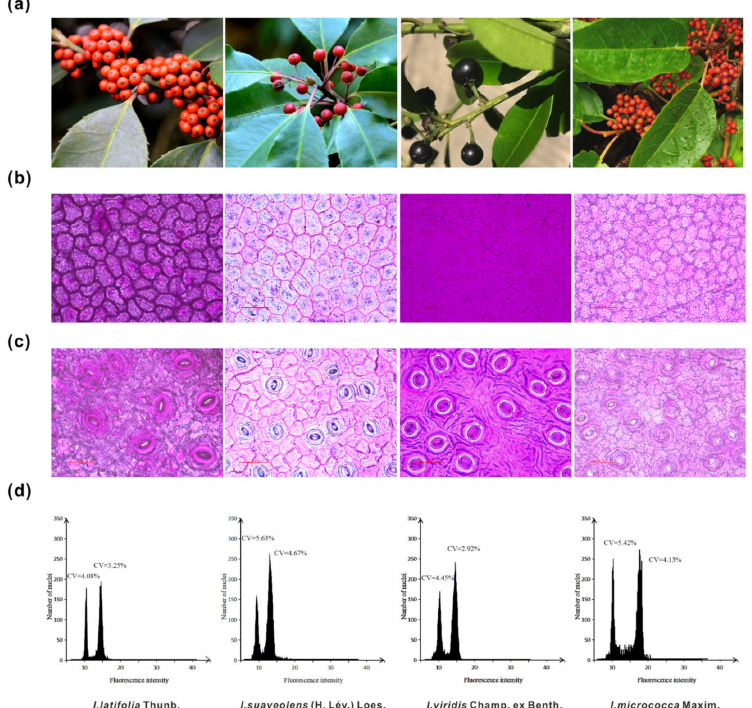
Figure 1. Analyses of the morphological traits and the fluorescent histograms of DNA content in four Ilex species. ( a ) The phenotypes of leaves and fruits; ( b ) LEC images; ( c ) STA and STD images; ( d ) flow cytometry (FCM) histograms obtained from leaves of four Ilex species. Nuclear DNA was stained with PI, using tomato ( S. lycopersicum ) as the internal